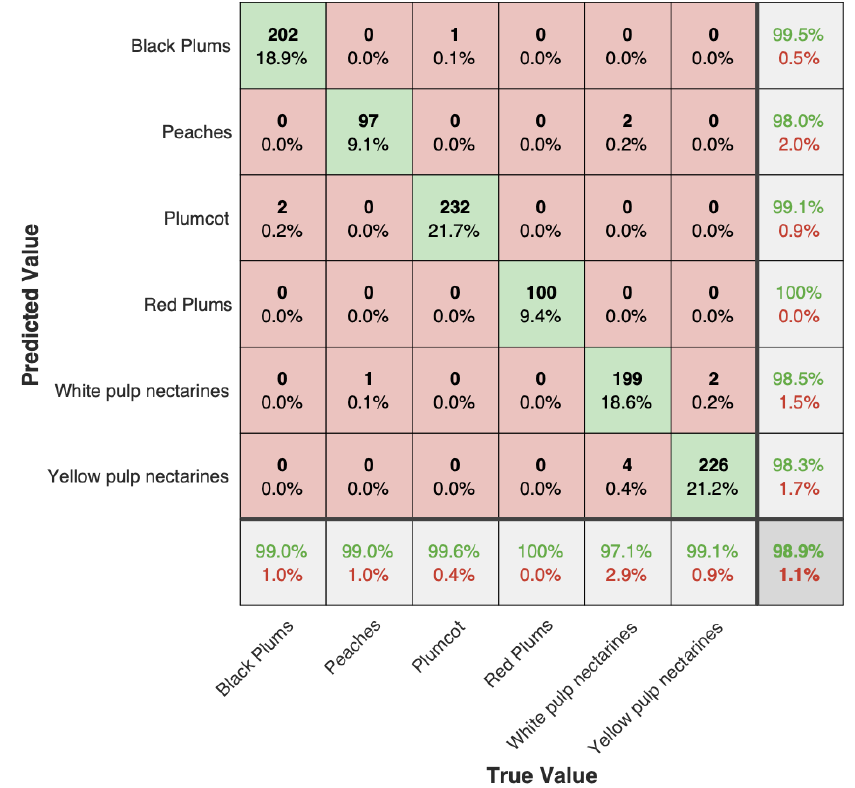
Figure 6. Confusion matrix of the validation group. The green squares represent the number of TP samples, the light pink squares represent the number of samples that were incorrectly classified, the green values represent the percentage of TP samples and the red values represent the percentage of samples that were incorrectly